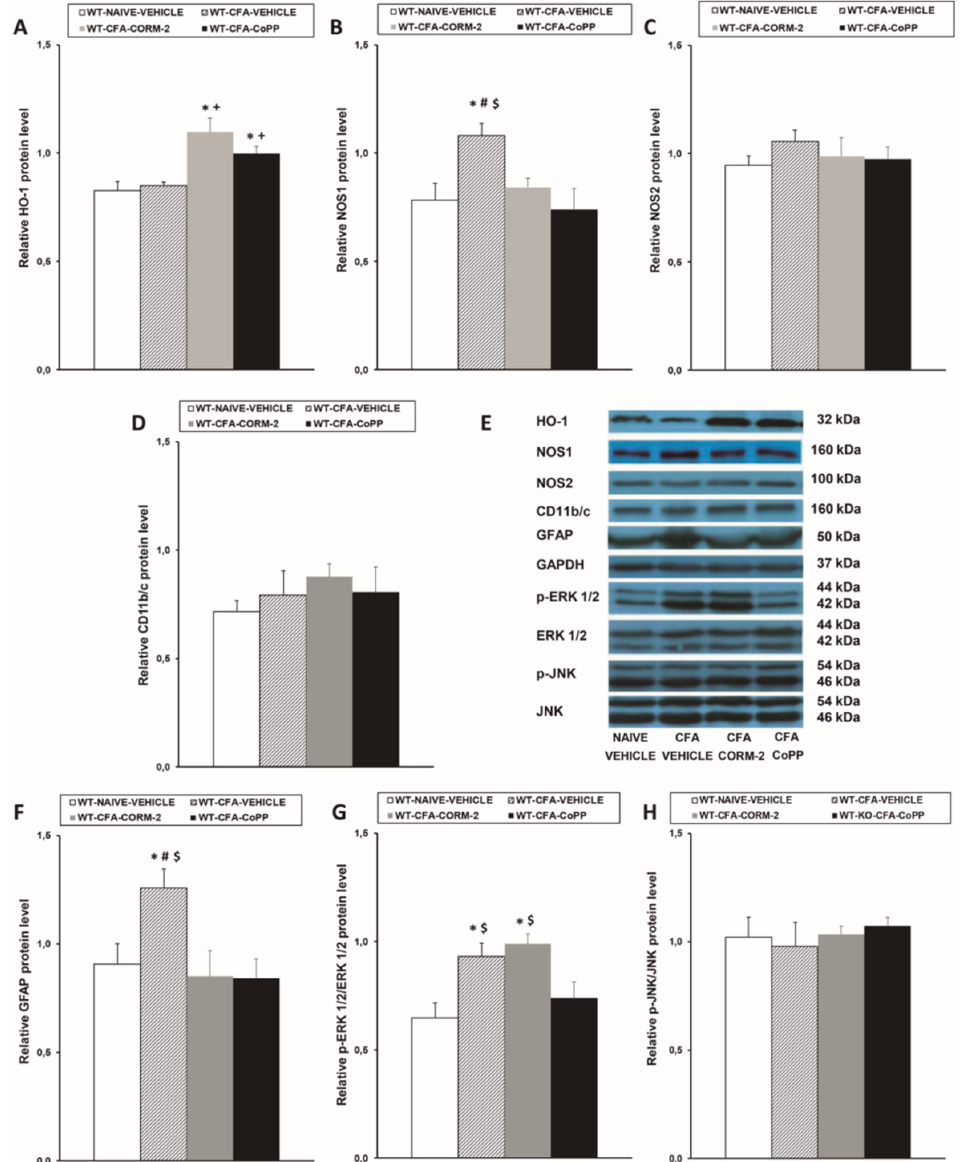
Figure 2. E ff ects of CoPP and tricarbonyldichlororuthenium(II) dimer (CORM-2) on the protein levels of HO-1, NOS1, NOS2, CD11b / c, GFAP, p-ERK 1 / 2, and p-JNK in the LC of WT mice. Protein levels of HO-1 ( A ), NOS1 ( B ), NOS2 ( C ), CD11b / c ( D ), GFAP ( F ), p-ERK 1 / 2 ( G ), and p-JNK ( H ) in the LC from CFA-injected WT mice treated with vehicle, CORM-2, or CoPP are represented. These levels in naïve mice treated with vehicle are also represented as controls. In all panels, * denotes significant di ff erences vs. naïve vehicle-treated mice, + denotes significant di ff erences vs. CFA-injected mice treated with vehicle, # denotes significant di ff erences vs. CFA-injected mice treated with CORM-2, and $ denotes significant di ff erences vs. CFA-injected mice treated with CoPP ( p < 0.05, one-way ANOVA, Student–Newman–Keuls test). Examples of western blots for HO-1 (32 kDa), NOS1 (160 kDa), NOS2 (100 kDa), CD11b / c (160 kDa), GFAP (50 kDa), GAPDH (37 kDa), p-ERK 1 / 2 / total ERK 1 / 2 (42–44 kDa), and p-JNK / total JNK (46–54 kDA) are shown ( E ). The levels of phosphorylated proteins are indicated relative to the corresponding total protein levels, while the levels of the remaining proteins are relative to those of GAPDH. Results are expressed as mean ± SEM; n = 4 samples per